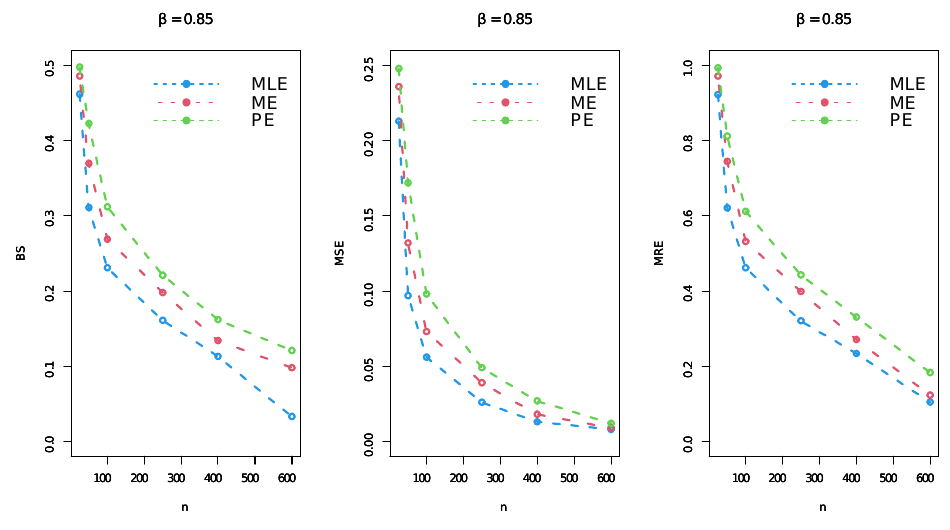
Figure 7. Simulation visualization plots for β = 0.85.